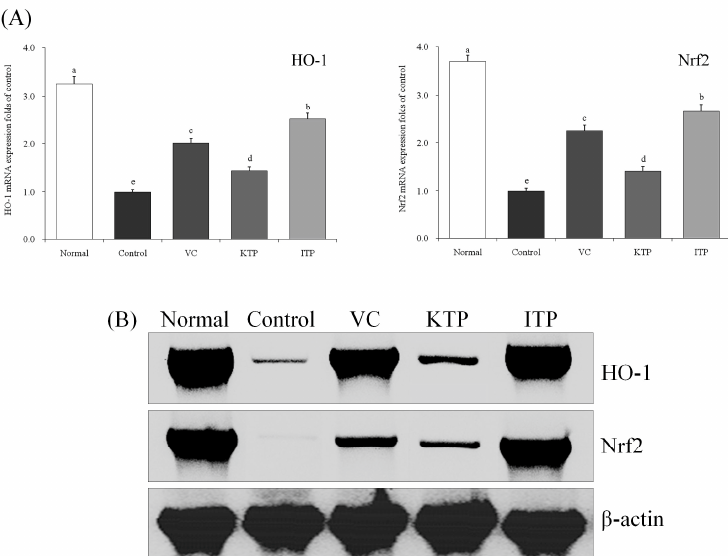
Figure 9. Expression of mRNA ( A ) and protein ( B ) for HO-1 and Nrf2 in spleen of mice. a–e Mean values with different letters in the same bar represent significant differences ( p < 0.05) according to Duncan’s multiple-range test. VC: vitamin C (200 mg/kg body weight); KTP: Kuding tea polyphenols (200 mg/kg body weight); ITP: insect tea polyphenols (200 mg/kg body weight).